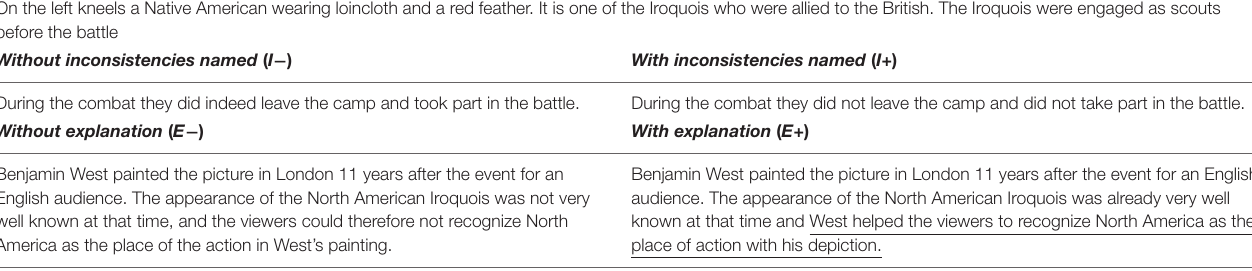
TABLE 1 | Example of text for the native American in wests painting “the death of general wolfe” for the four conditions. On the left kneels a Native American wearing loincloth and a red feather. It is one of the Iroquois who were allied to the British. The Iroquois were engaged as scouts before the battle Without inconsistencies named ( I − ) With inconsistencies named ( I +) During the combat they did indeed leave the camp and took part in the battle. During the combat they did not leave the camp and did not take part in the battle. Without explanation ( E − ) With explanation ( E +)